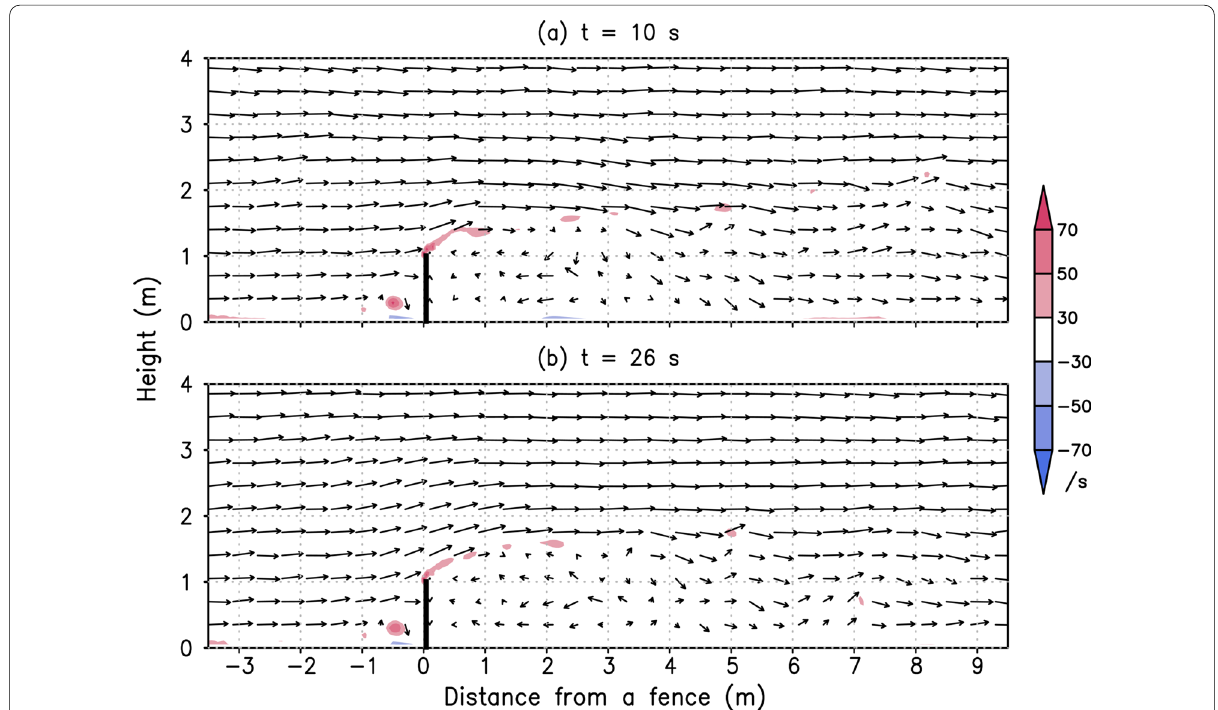
Fig. 9 Snapshots of wind vectors (vectors) and vorticity (shading) around the three-dimensional fence in the cross section along y and b 26 s. The position of the fence is shown by a solid